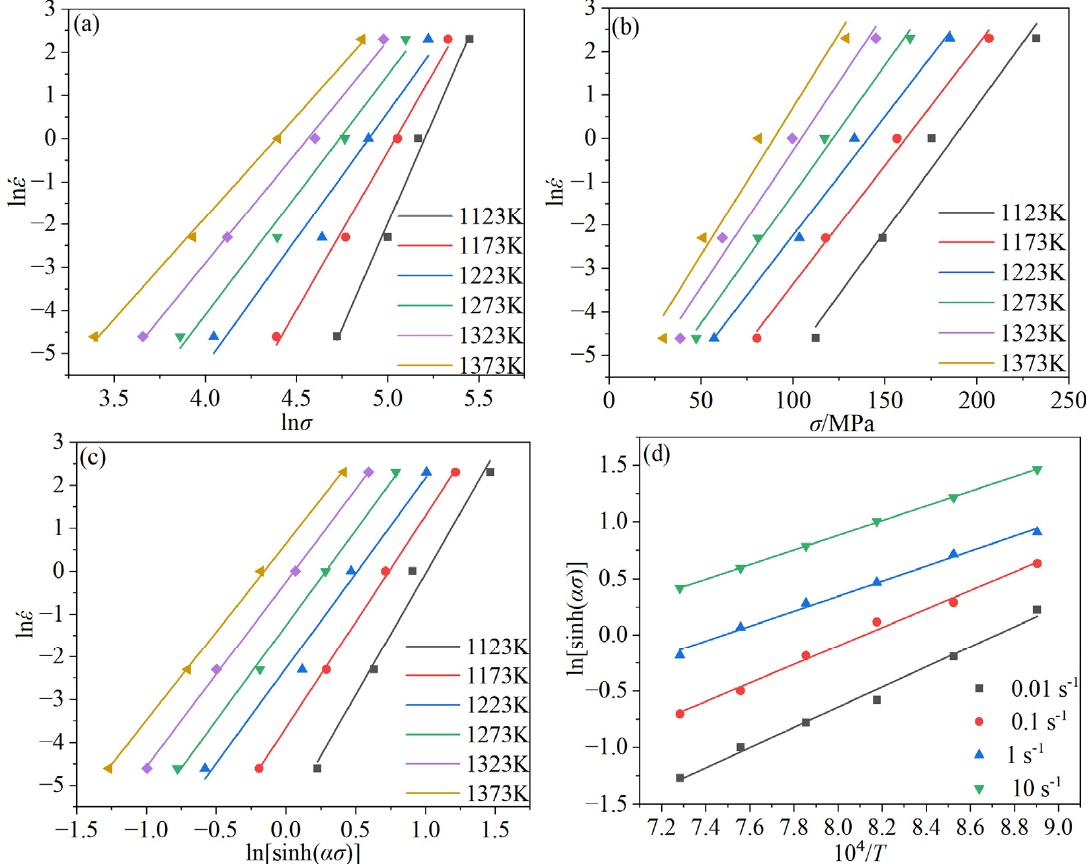
Figure 7. Relationship between: ( a ) ln σ − ln . ε ; ( b ) σ − ln . ε ; ( c ) ln [ sinh ( ασ )] − ln . ε ; ( d ) 10 4 / T − ln [ sinh ( ασ )] . In this paper, the Zener–Hollomon parameter is introduced, which comprehensively reflects the influence of deformation temperature and strain rate on the thermal deformation behavior of metals. Zener–Hollomon parameters are expressed as: